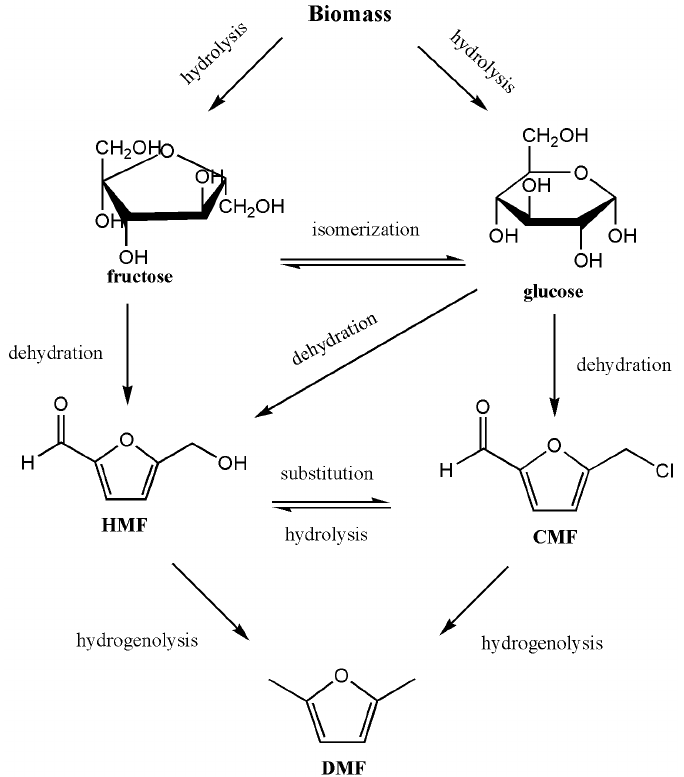
Figure 6. Pathway of DMF preparation from biomass. Adapted from [35].